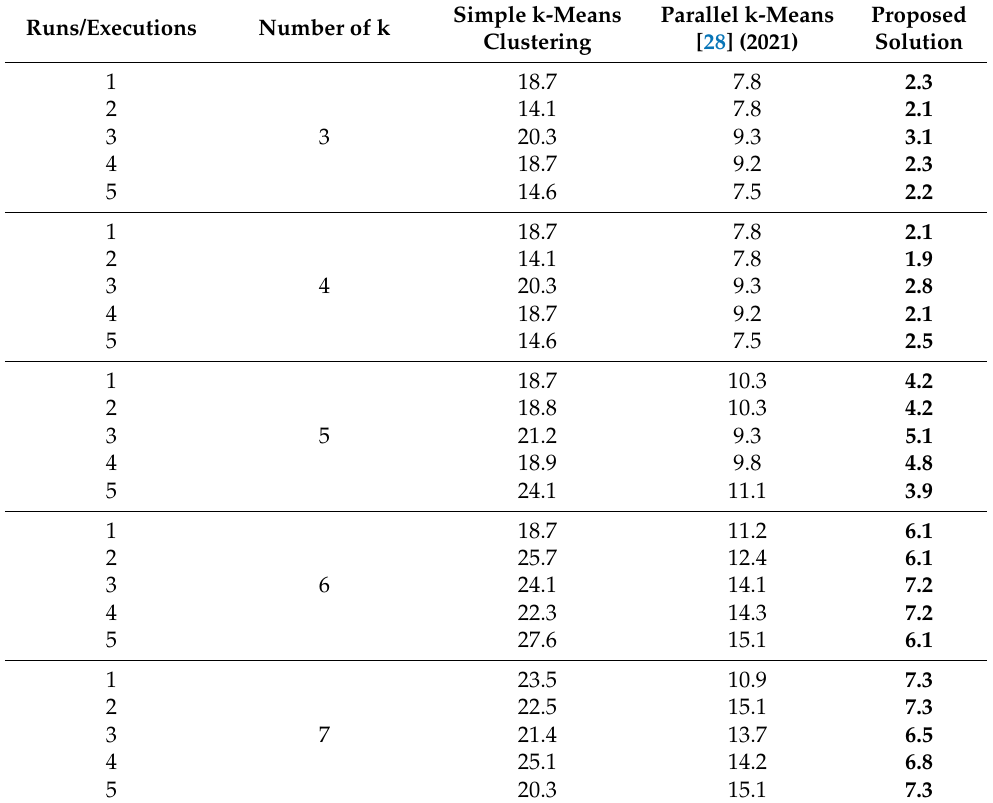
Table 7. Time elapsed for k clustering in milliseconds.